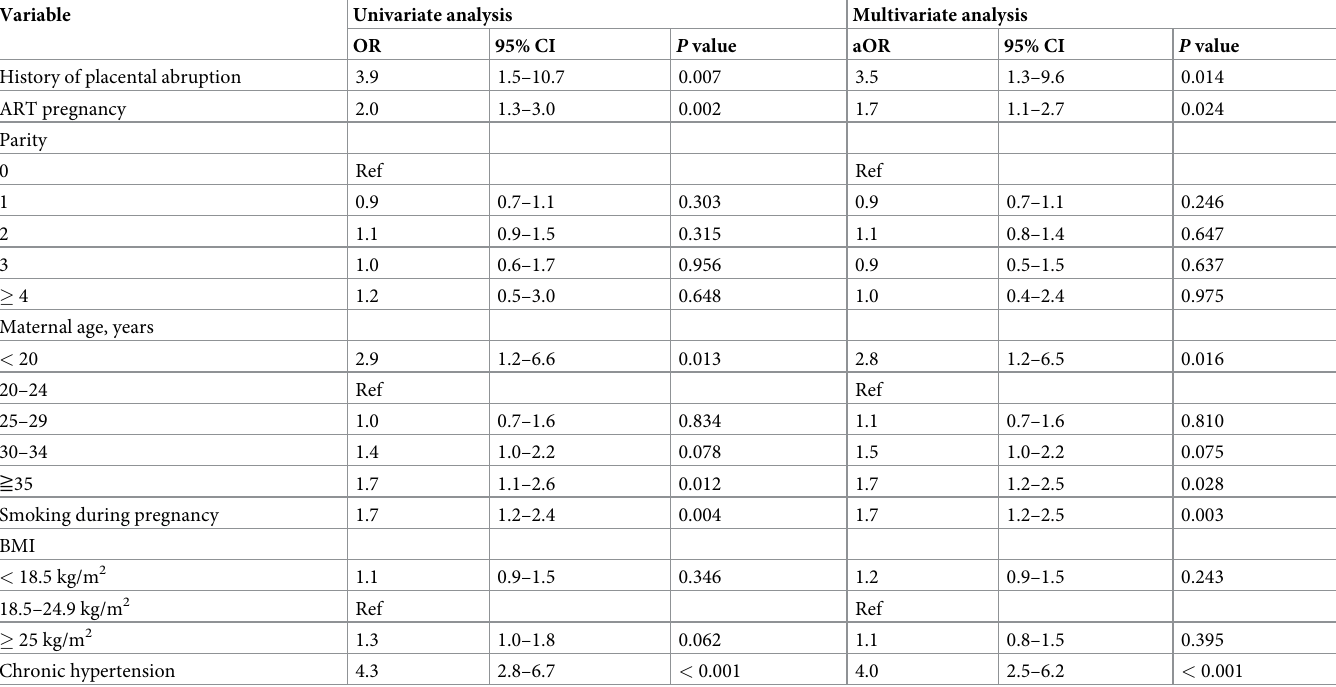
Table 2. Factors associated with placental abruption: Results from univariate and multivariate logistic regression analyses.